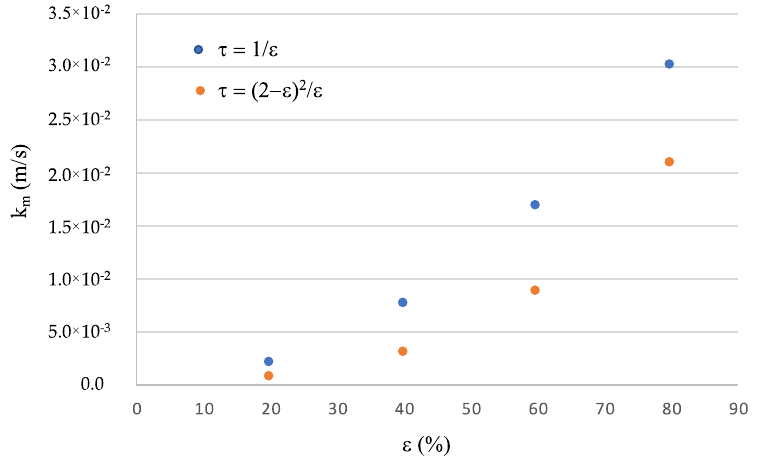
Figure 8. Mass transfer coefficient of the membrane as function of the membrane porosity and structure.